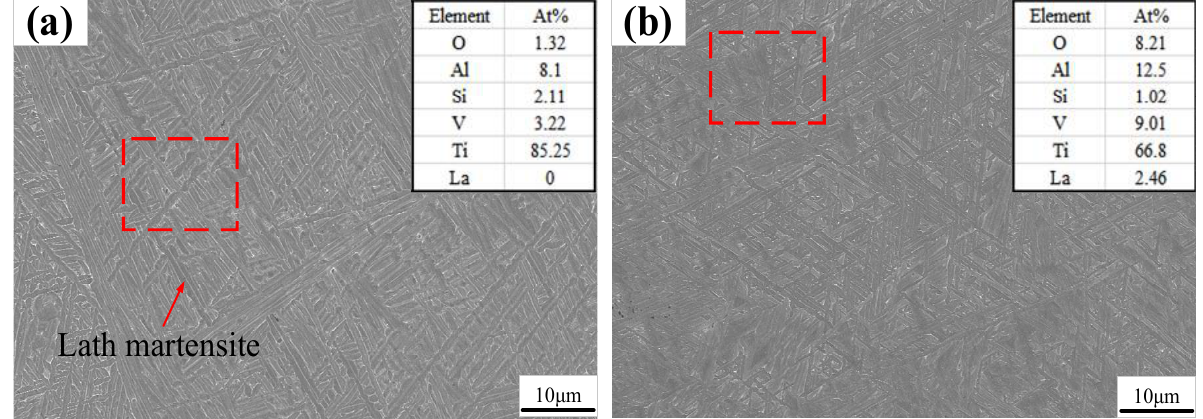
Figure 5. SEM images: ( a ) without La 2 O 3 ; ( b ) with La 2 O 3 .